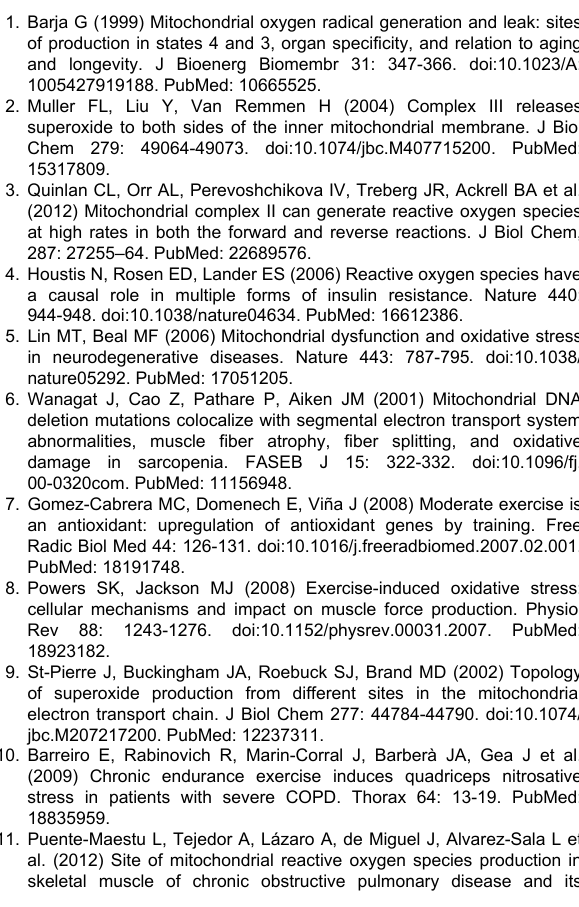
Figure S1. Metabolic and behavioral measurements before and after separation into study groups. Initial measurements of (A) body weight, (B) VO , (C) VCO , (D) total food intake and 2 2 (E) X-axis ambulatory activity during light and dark cycles in Sod2 +/+ and Sod2 +/- mice. Measurements in the same mice after separation into groups of (F) body weight (G) VO , (H) 2 VCO , (I) total food intake and (J) X-axis ambulatory activity. 2 Data are mean±SE and contain no significant differences between groups.